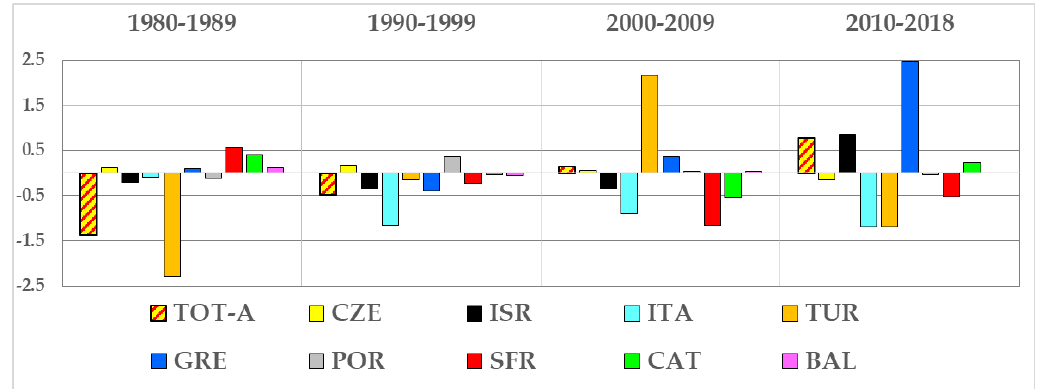
Figure 5. Decadal trends of #FF in SA and TOT-A, represented by the slope of the trend in each SA.